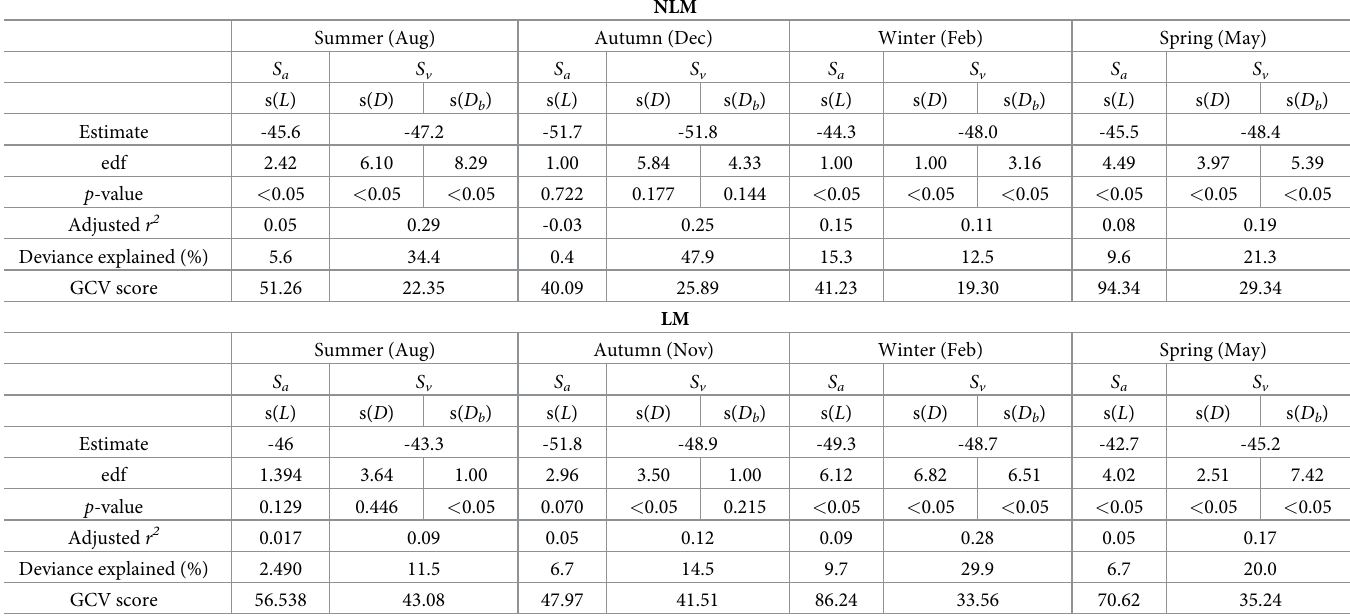
Table 5. Statistical results of relationship between Sa and L , Sv and D , D b in each survey. L : distance from shore; D : depth; D b : distance from bottom The effective degrees of freedom (edf), which is summary statistic of GAMs, were used to quantify the strength of non-linearity in driver response